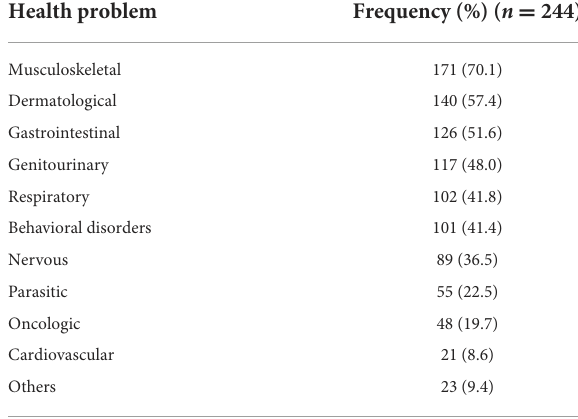
TABLE 2 Categories of health problems treated with natural products by the Spanish small animal veterinarians